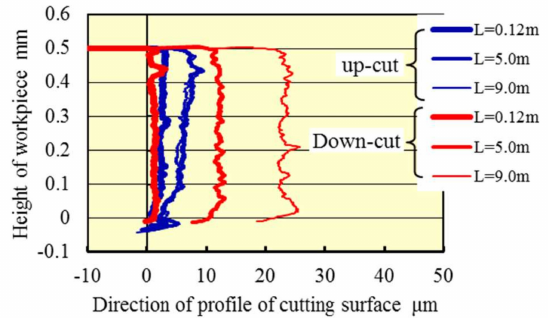
Figure 7. Machined surface profile ( N s = 100,000 min − 1